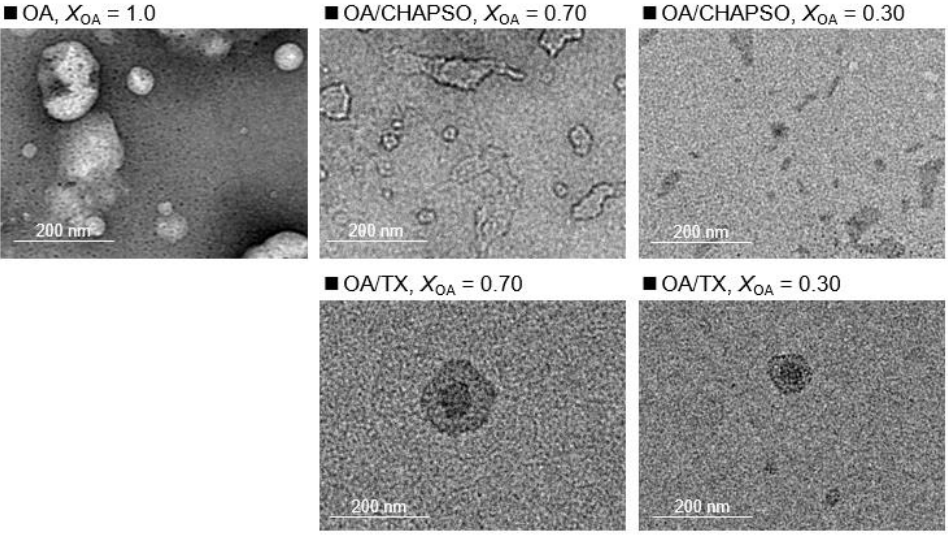
Figure 3. TEM images show a 20 mM OA vesicle ( X OA = 1.0), and 20 mM OA/detergent bicelles ( X OA = 0.30 and 0.70).